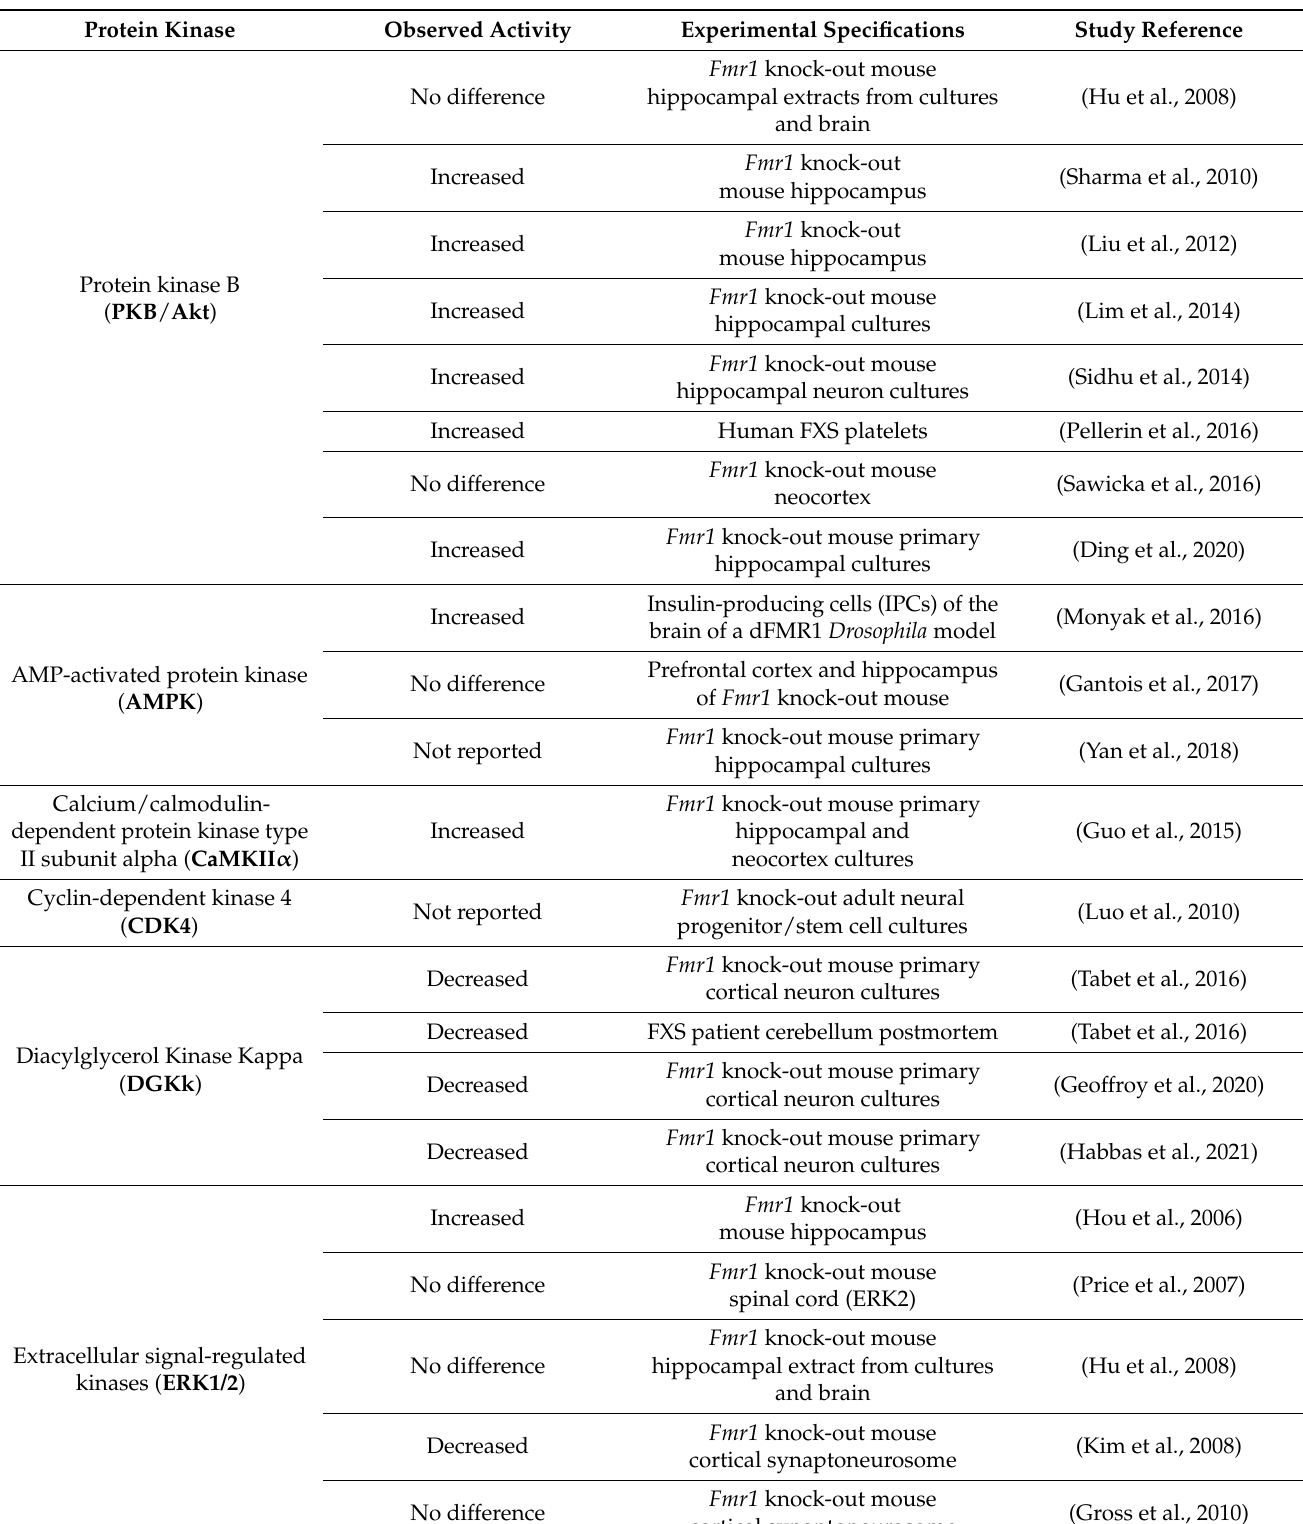
Table 1. Overview of the FXS studies examining dysregulated protein